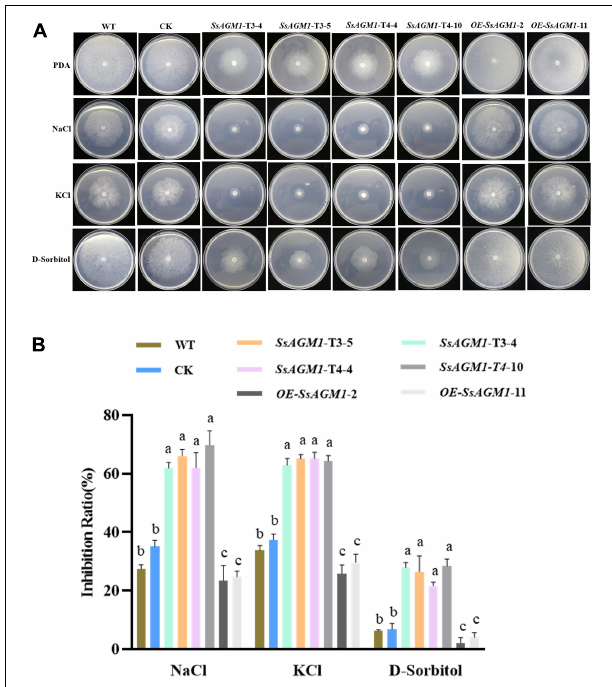
FIGURE 5 | SsAGM1 contributes to the response to osmotic stress in Sclerotinia sclerotiorum. (A) The growth phenotypes of wild-type strain, control strain, gene-silenced transformants, and overexpression transformants on PDA supplemented with NaCl, KCl, and D-sorbitol for 48 h after inoculation. (B) The inhibition rate of hyphae growth on PDA supplemented with different external osmotic substances. Inhibition rate = (diameter of untreated strain - diameter of treated strain)/(diameter of untreated strain × 100%). One-way ANOVA; n = 3; different letters indicate statistically significant differences ( p < 0.05). Data represent means ± SD. WT, Wild-type strain; CK, the control